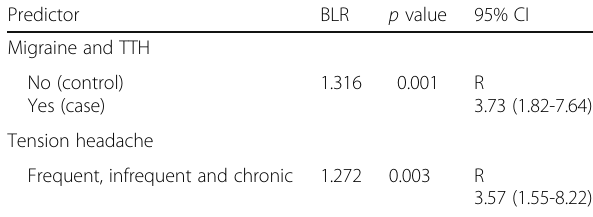
Table 3 Predictors of the likelihood of occurrence of hypothyroidism